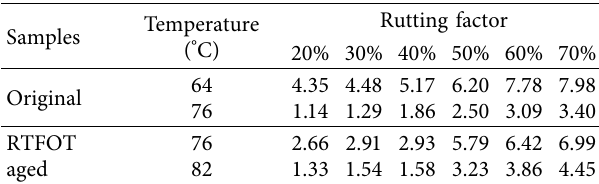
Figure 10: Rheological parameters of six CRMAs: (a) complex shear modulus and phase angle; (b) storage and loss moduli; and (c) complex viscosity. Table 4: Test results of rutting factor (kPa).